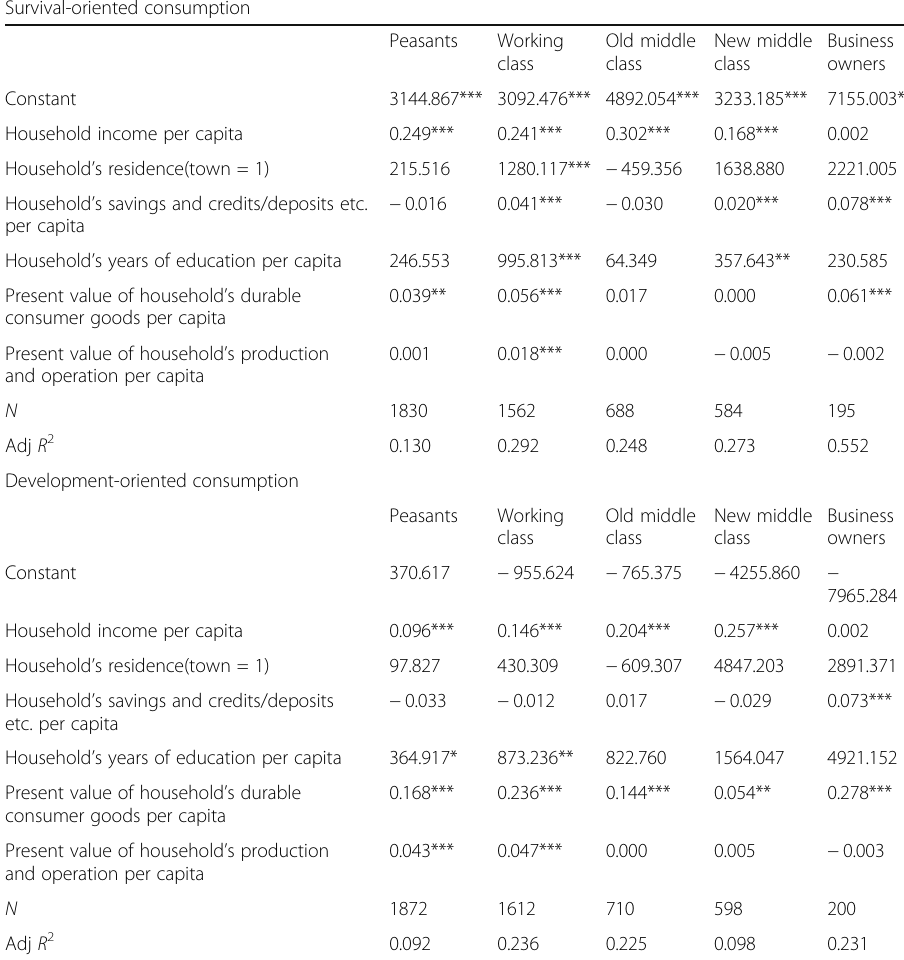
Table 2 Distribution of MPC by class in terms of survival/development-oriented consumption (extended